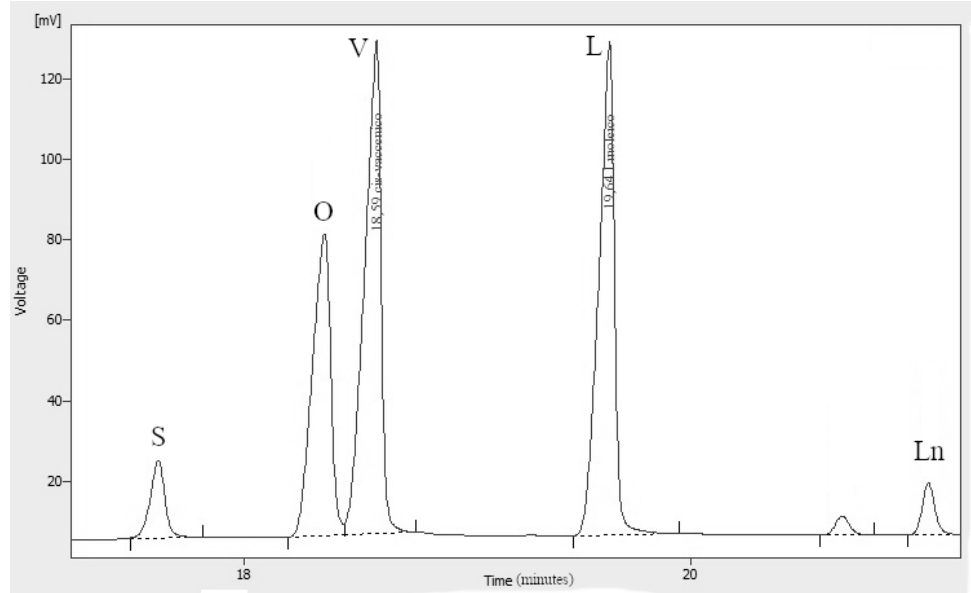
Figure 2. Expanded region of interest in the gas-chromatographic flame ionization detection (GC-FID) profile for Capparis spinosa oil; oleic (O) and cis -vaccenic (V) methyl esters are resolved for the quantification. In the case of extra-virgin oil the O peak is around 20 times more than V. Other labelled signals are linolenic (Ln), linoleic (L) and stearic (S) esters